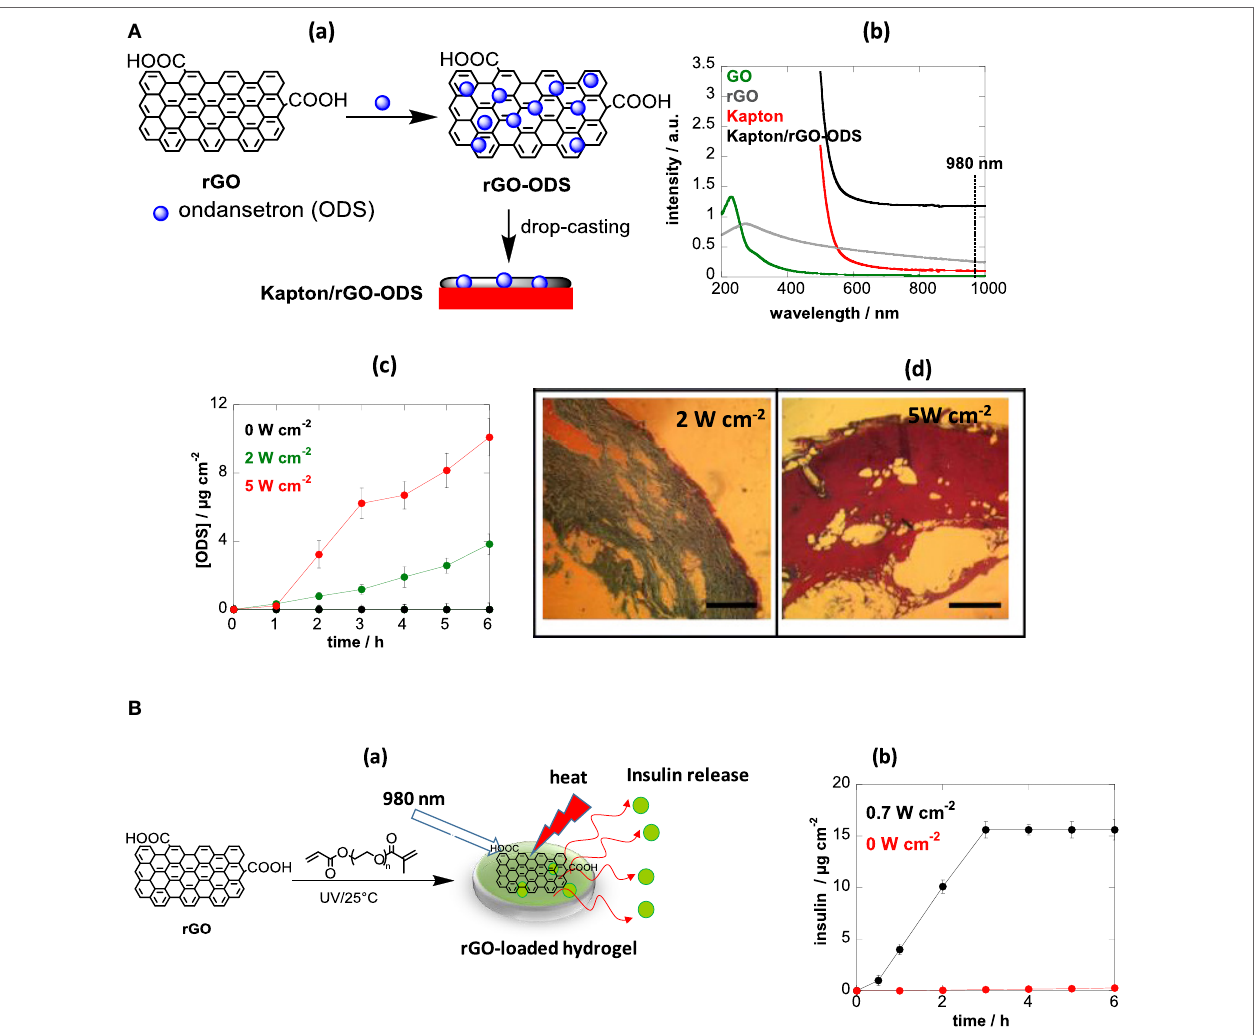
FigURe 5 | (A) (a) Fabrication of a drug-loaded reduced graphene oxide (rGO)-modified skin patch, (b) UV/Vis spectra of graphene oxide (GO), rGO, Kapton and Kapton/rGO-ondansetron (ODS), (c) in vitro permeation profiles of ODS through porcine skin from Kapton/rGO-ODS patches formed by mixing 500-µg/mL ODS with 1-mg/mL rGO upon light irradiation for 10 min using a continuous wave laser at 980 nm at different laser power densities, and (d) histology of pig ear skin after treatment with different laser power densities at 980 nm for 10 min. Scale bar = 0.5 mm [reprint with permission from Teodorescu et al. (2017) and Teodurescu et al. (2017)]. (b) (a) Formation of insulin-loaded photothermal active hydrogel and (b) in vitro permeation profiles of insulin [reprint with permission from Teodurescu et al.